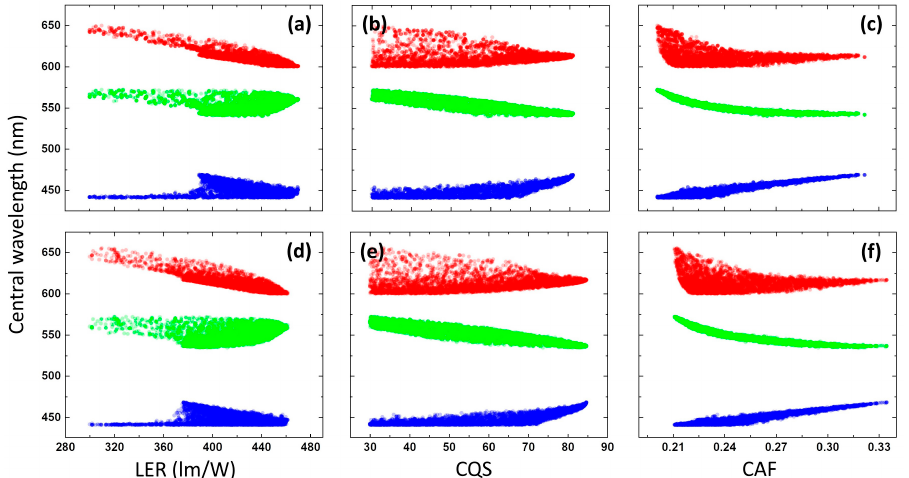
Figure 4. Correlations between the emission peak wavelengths and the objectives for optimized RG P B-type SSL, where ( a – c ) Gaussian model and ( d – f ) SP7 model are applied in the optimization.